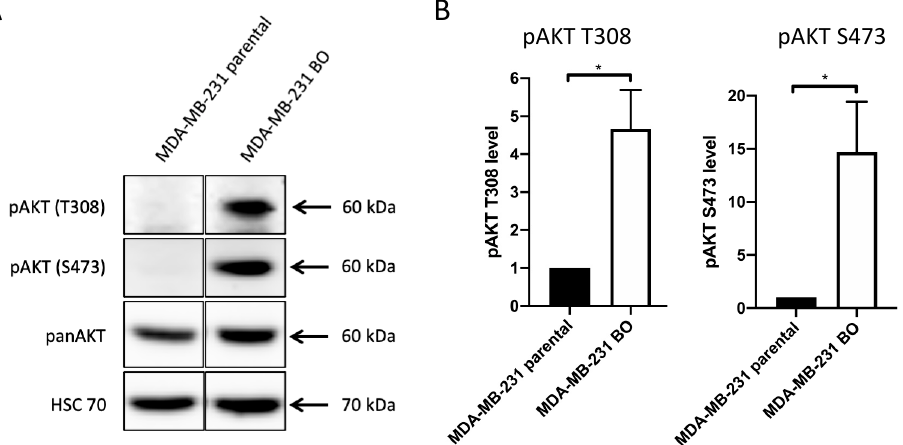
Figure 1. The bone-seeking subline MDA-MB-231 BO exhibits constitutively elevated pAKT levels compared to MDA-MB-231 parental cells: ( A ) Western blot assay was performed to determine pAKT T308, pAKT S473 and panAKT levels using antibodies directed against the indicated proteins. HSC70 functions as a loading control. ( B ) Relative levels of pAKT T308 and pAKT S473 in the bone-seeking MDA-MB-231 subline compared to MDA-MB-231 parental cells were quantified from Western blot analysis of triplicates. Data were normalized to Ponceau staining and panAKT level. Bars indicate mean with SD; * = p < 0.05.